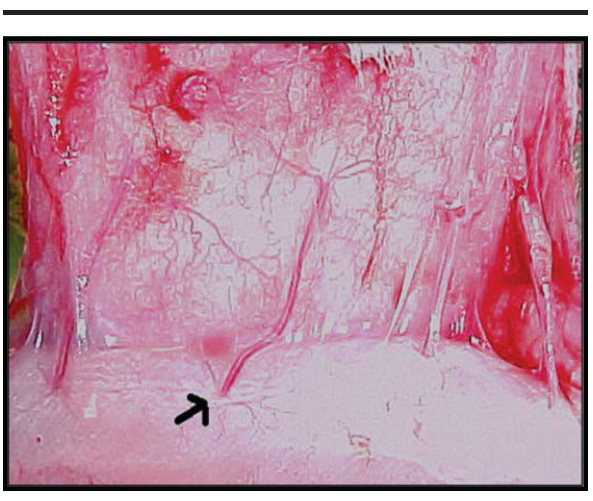
markings: (a) horizontal line over xyphoid; (b) horizontal line over anterosuperior iliac spines; (c,d) vertical lines over posterior axilary line